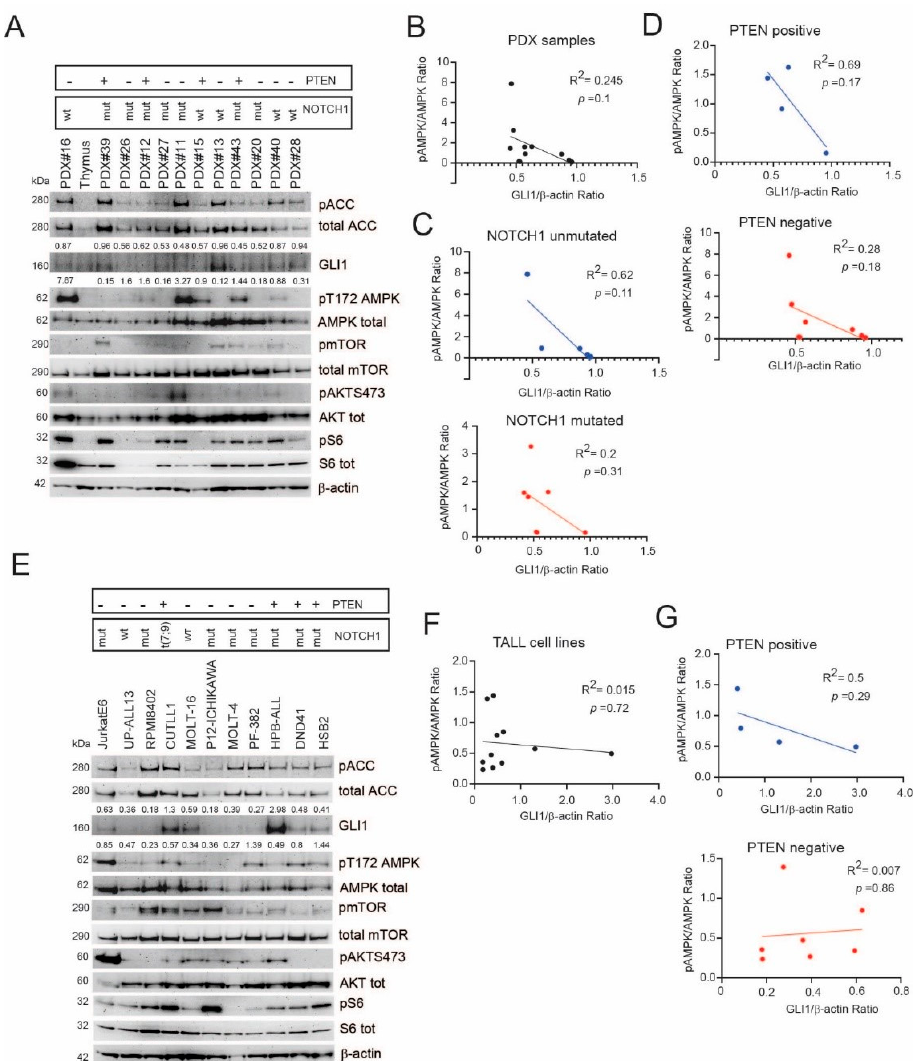
Figure 3. Sustained AMPK activation in a subset of T-ALL cells (PDX samples and cell lines) is associated with low GLI1 expression. ( A ) Western blot evaluating the expression levels in PDX samples of activated AMPK (phospho AMPK (T172)), AMPK targets (phospho ACC1 (S79)), GLI1, mTORC activation (phospho mTOR (S2448), phospho AKT (S473), phospho S6 (S235/236)). Total ACC1, total AMPK, total AKT1/2/3, total S6, and β -actin were used as loading controls. Normalized GLI1 protein expression (relative to its β -actin loading control) is shown. The ratio between phosphorylated and total AMPK α protein is shown. NOTCH1 mutational status and PTEN protein expression status is also reported. NOTCH1 wt = unmutated; NOTCH1 mut = mutated; +, expressed; -, not expressed. ( B ) Linear regression analysis of the relationship between normalized GLI1 protein levels and activated AMPK (pAMPK/AMPKtotal) in all PDX samples. ( C ) Linear regression analysis of the relationship between normalized GLI1 protein levels and activated AMPK (pAMPK/AMPKtotal) in PDX samples divided on the basis of NOTCH1 mutational status. ( D ) Linear regression analysis of the relationship between normalized GLI1 protein levels and activated AMPK (pAMPK/AMPKtotal) in PDX samples divided on the basis of PTEN expression. ( E ) Western blot evaluating the expression levels in T-ALL cell lines of activated AMPK (phospho AMPK (T172)), AMPK targets (phospho ACC1 (S79)), GLI1, mTORC activation (phospho mTOR (S2448), phospho AKT (S473), phospho S6 (S235/236)). Total ACC1, total AMPK, total AKT1/2/3, total S6, and β -actin were used as loading controls. Normalized GLI1 protein expression (relative to its β -actin loading control) is shown. The ratio between phosphorylated and total AMPK α protein is shown. NOTCH1 mutational status and PTEN protein expression status is also reported. NOTCH1 wt = unmutated; NOTCH1 mut = mutated; t(7;9) = translocation generating ICN1; +, expressed; -, not expressed. ( F ) Linear regression analysis of the relationship between normalized GLI1 protein levels and activated AMPK (pAMPK/AMPKtotal) in all T-ALL cell lines. ( G ) Linear regression analysis of the relationship between normalized GLI1 protein levels and activated AMPK (pAMPK/AMPKtotal) in T-ALL cell lines divided on the basis of PTEN